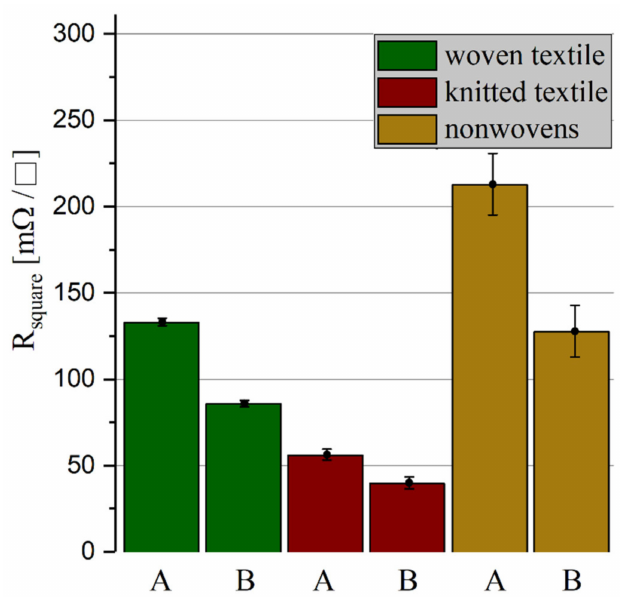
Figure 5. Sheet resistances of the three di ff erent fabrics before ( A ) and after ( B ) the influence of pressure and heat during lamination.